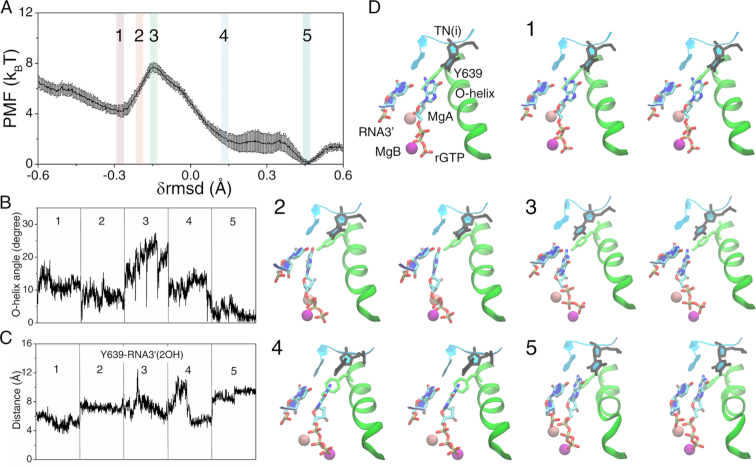
The PMF for the non-cognate rGTP bound RNAP complex from the on-path pre-insertion state to the insertion state and key structural measurements. (A) The PMF obtained from the umbrella sampling simulations along the collective reaction coordinate \documentclass[12pt]{minimal}
\usepackage{amsmath}
\usepackage{wasysym}
\usepackage{amsfonts}
\usepackage{amssymb}
\usepackage{amsbsy}
\usepackage{upgreek}
\usepackage{mathrsfs}
\setlength{\oddsidemargin}{-69pt}
\begin{document}
}{}${\rm{\delta rmsd}}$\end{document}. (B) The O-helix angle obtained from the five windows labeled on the PMF curve. (C) The distance between Y639 and RNA3′-2OH. (D) The five representative structures along the reaction coordinate (in stereo views). A pre-insertion configuration (config 1) with TN(i), Y639, O-helix, MgA/B, rGTP and RNA 3′ denoted is also shown.